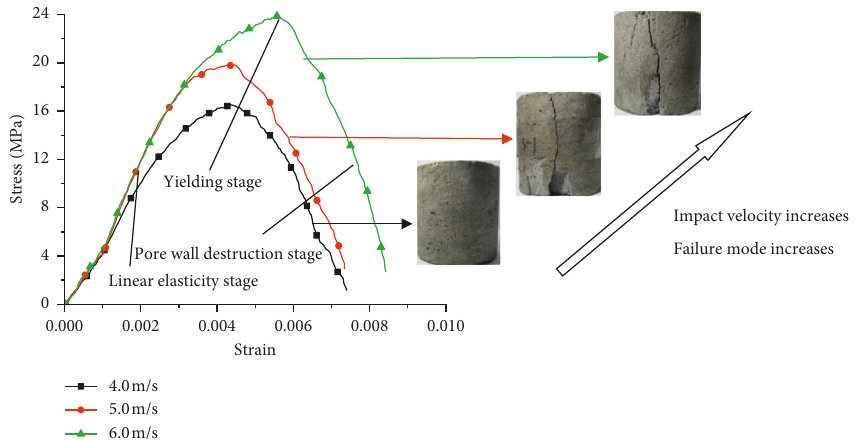
Figure 13: Foam concrete with fly ash stress-strain curve at 1,400kg/m 3 .